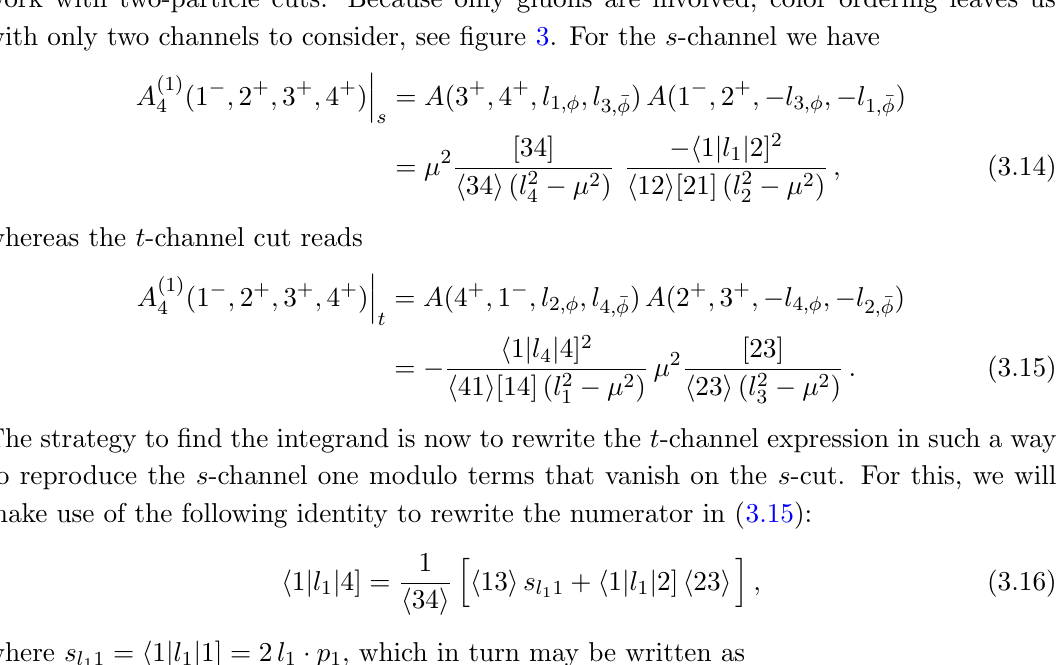
Figure 3 . The s - and t -channel cuts of the A (1) (1 (cid:0) ; 2 + ; 3 + ; 4 + ) amplitude in pure Yang-Mills.